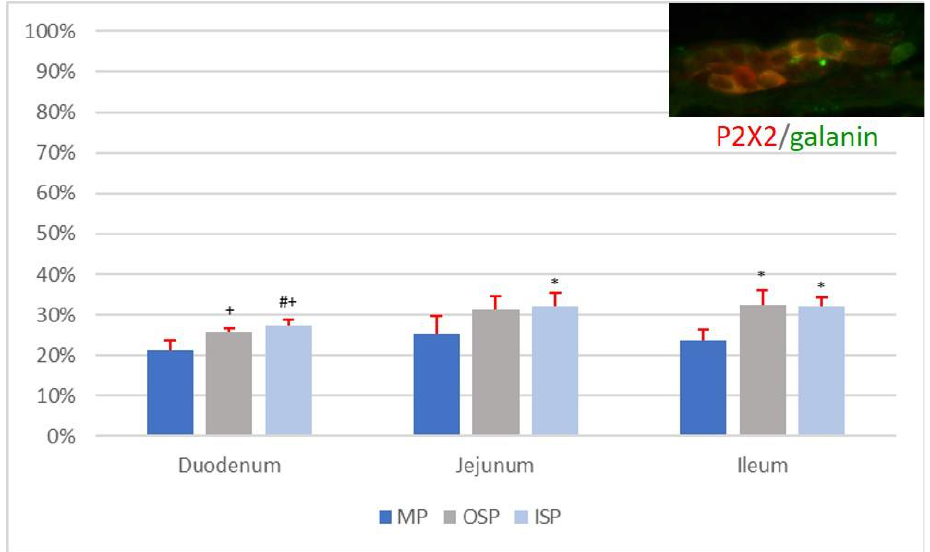
Figure 4. Percentage of P2X2-IR/galanin-IR neurons in individual nerve plexuses (MP, OSP, and ISP) of the duodenum, jejunum, and ileum. Statistically significant differences ( p < 0.05) between mean numbers of P2X2-IR/galanin-IR neurons present in analogous nerve plexuses of different sections of the small intestine are marked: * vs. duodenum, # vs. jejunum, + vs.